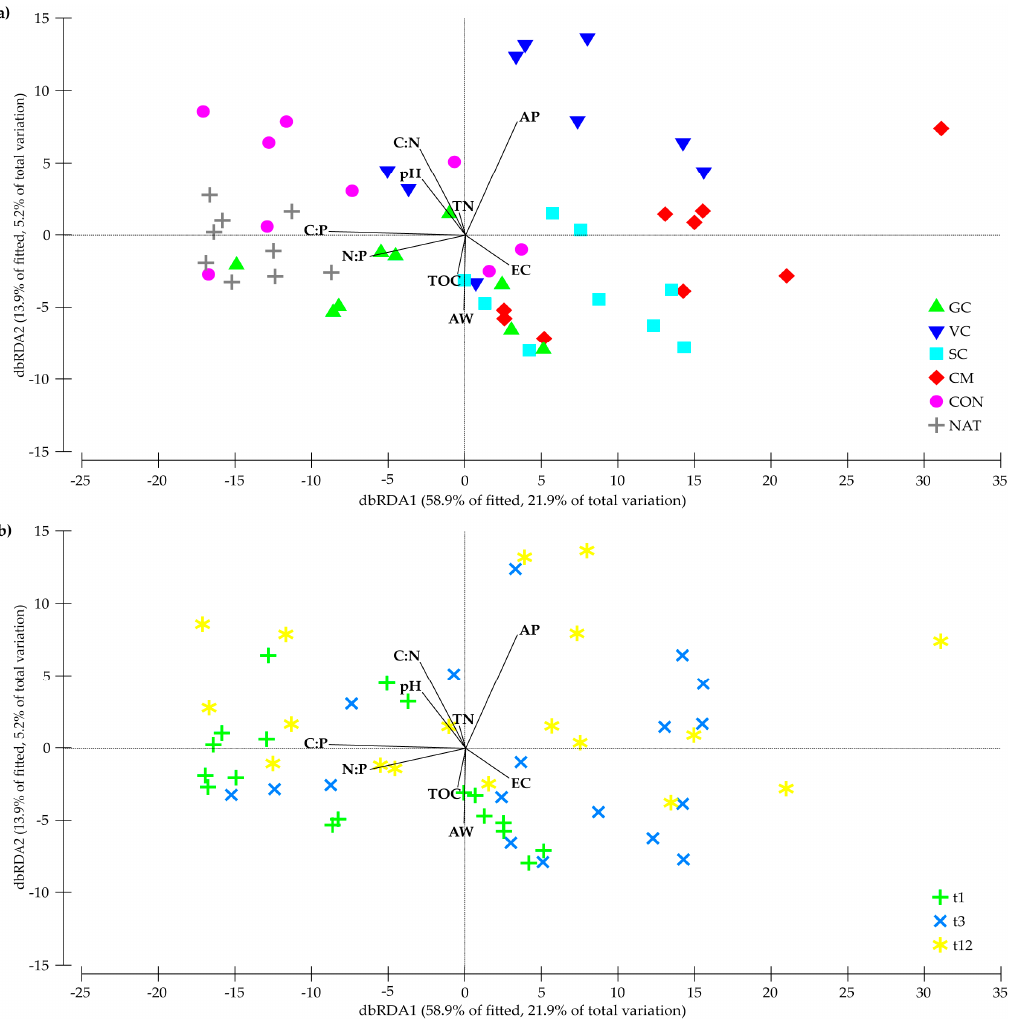
Figure 2. Distance-based redundancy analysis (dbRDA) of soil bacterial community and physico- chemical properties for restored, control, and natural reference soils ( a ), and for soil sampling campaign ( b ). EC: electrical conductivity; AW: available plant water; TOC: total organic carbon; TN: